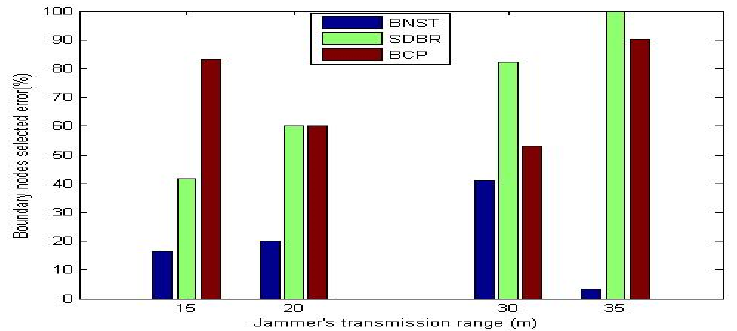
Figure 9. Boundary nodes recognized by BNST, SDBR, and BCP.